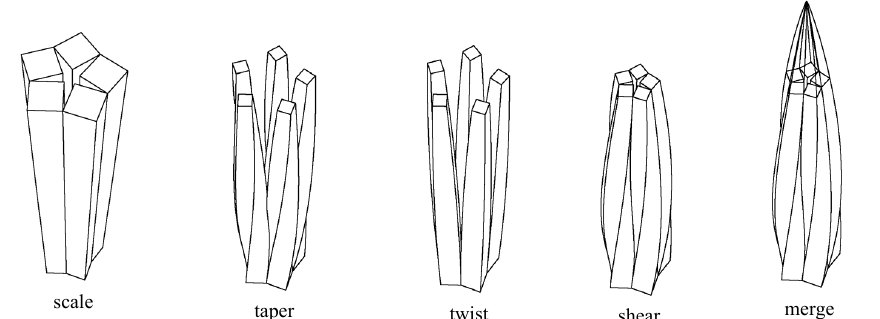
scale taper twist shear merge Fig. 1abc: Okhta Gazprom tower, under construction in St. Petersburg, Russia (by RMJM); superstructure sideview; topview; genrating process. The volume can, for example, be generated in by positioning 5 cubes on the ground floor as a five-pointed star (Figure 1d). Then scaling the cubes upwards, tapering and twisting each volume around its individual central vertical axis. Next each axis is bent sideways while keeping the floors horizontal (‘shearing’) to make the volume’s tops touch. The model can also be scripted. Then for example the squares are drawn as ground floor plan. Similar curved trajectories for the floorplans to follow are described, or constructed on the screen. The floorplans subsequently are scripted to get smaller and rotate while moving upward along the trajectories. The top was added later in the above sequence, to outline the geometry of the first drawings more clearly. It should have been shown from the beginning, as integral part with the lower